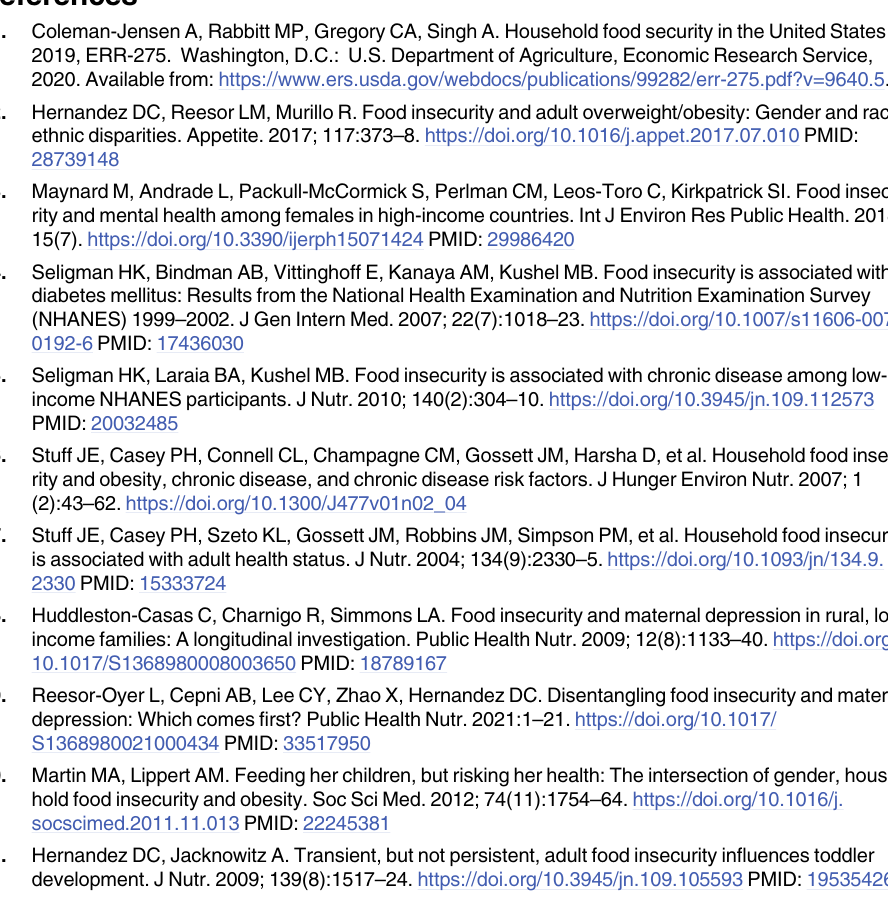
S2 Table. Classification probabilities for the most likely latent class membership: Five class